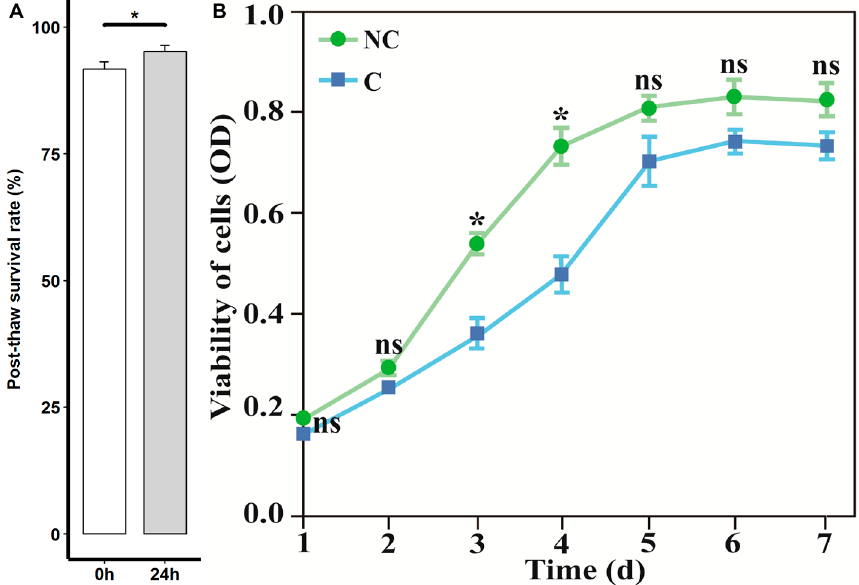
Figure 2. The cellular-viability measurement of fi broblasts. ( A ). The post-thaw survival rate of cryopreserved cells at 0 h and 24 h. ( B ). The growth curves of cryopreserved (C) and non-cryopreserved (NC) cells. “*” represents adjusted p < 0.05; “ns” indicates non-signi fi cant di ff erences.